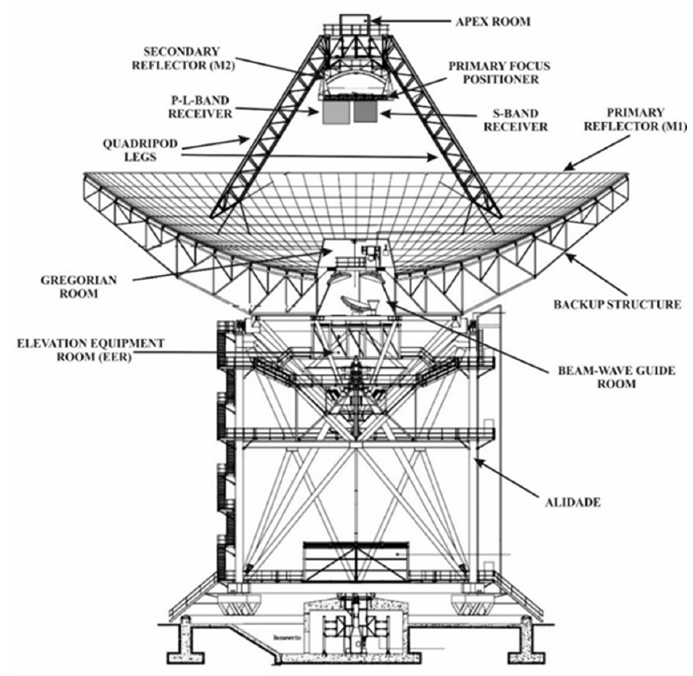
Figure 2. Sketch of the Sardinia Radio Telescope.